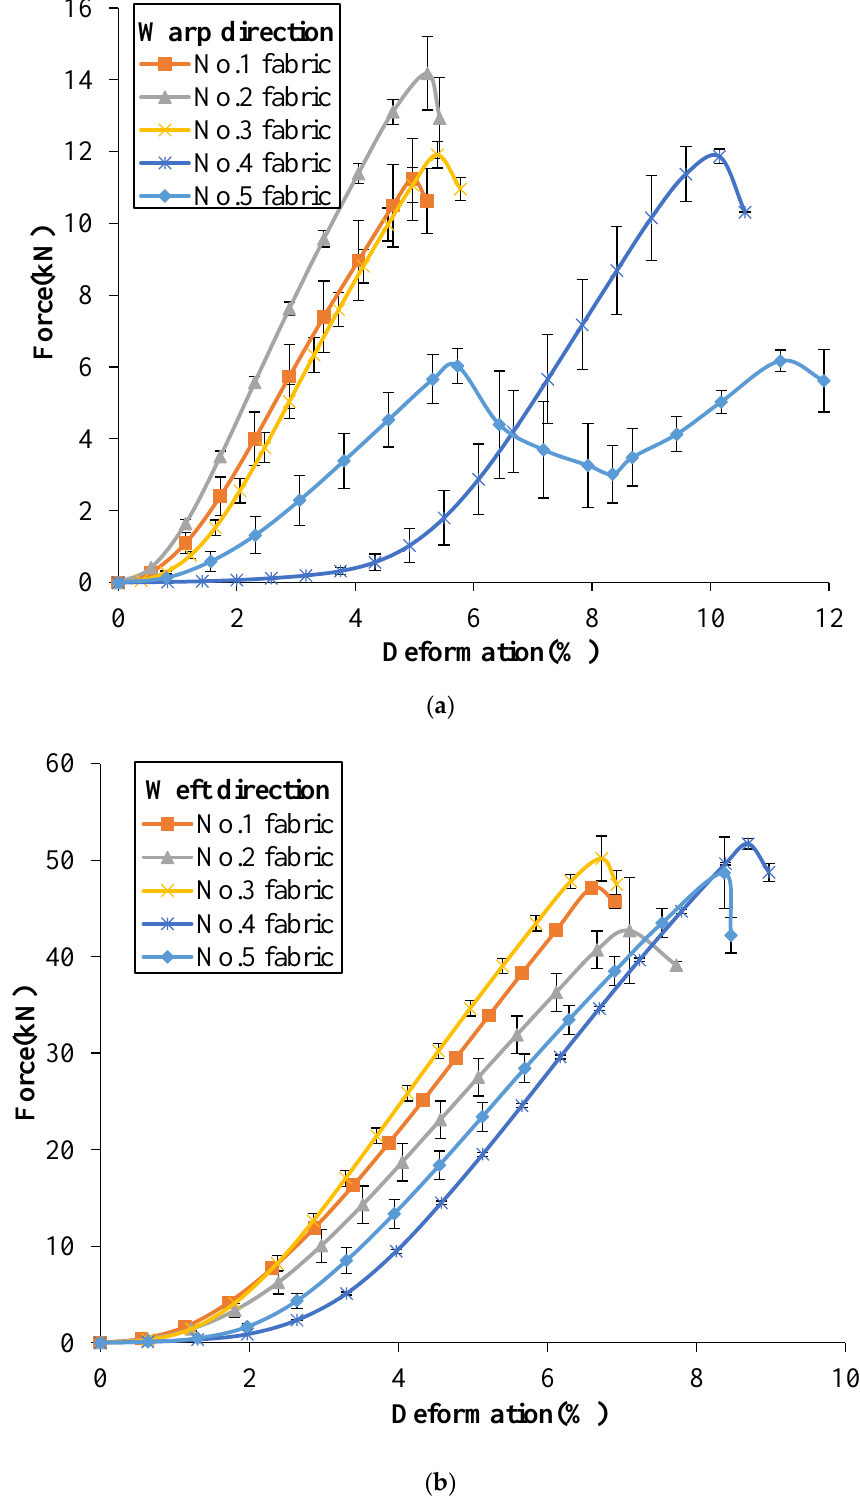
Figure 6. Tensile force/tensile deformation curves of 3DWIFs in warp ( a ) and weft ( b ) directions. In Figure 6a, the slope of the initial linear region of the F1, F3 and F4 fabrics was very similar. The extension slope is slightly smaller than the one of the F2 fabric but more important than the two slopes of the F5 fabric. The F5 fabric exhibited two peaks in the extension stage in the warp